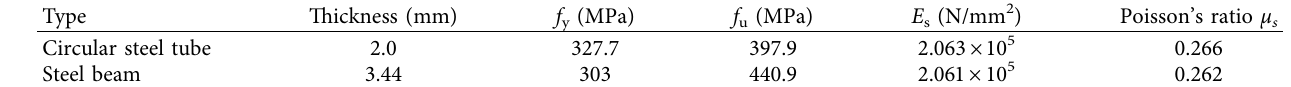
Table 1: Mechanical properties of steel materials.